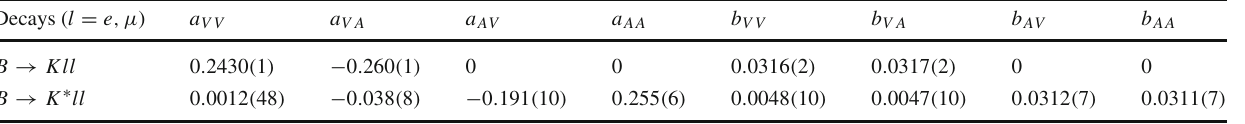
Table 5 Numerical coefficients defined in Eq. (41) for l = e ,μ , which are computed in the [ 1 . 1 , 6 ] GeV 2 bin by using the B → K and B → K ∗ form factors from Ref. [35] and Ref. [42], respectively. The